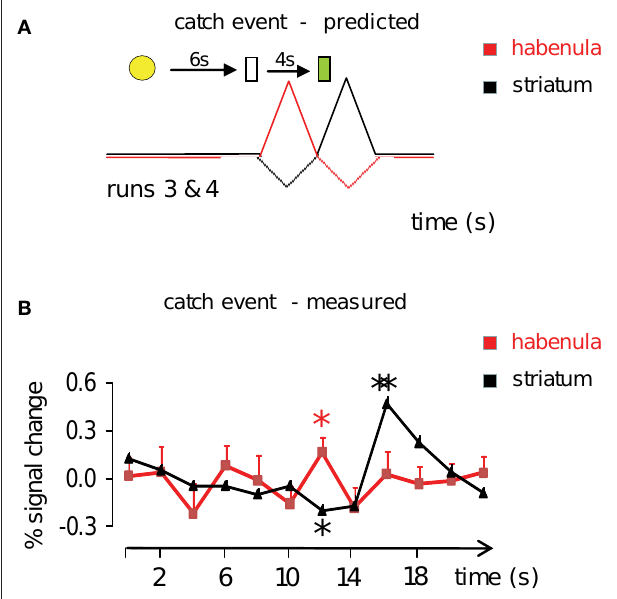
FIguRe  | Habenula activation to negative prediction errors. Striatal (black) and habenula (red) time series derived from 12 catch trials in runs 3 and 4 (see Figure  ). (A) Predicted (Based on Matsumoto and Hikosaka, 2007, we qualitatively drew the negative-going striatal and habenular responses as smaller than the positive responses.) and (B) . Measured habenular and striatal responses are shown. The red trace is the average time series from habenula voxels identified by the anti-correlational method presented in Figure  . The habenula voxels give a positive-going response to the non-delivery of expected juice ( p = 0.021). The striatal voxels were identified in Figure  with a standard GLM contrast and show a negative-going response to unexpected juice non-delivery (black asterisk, t-test p = 0.0014) and a positive-going response to unexpected juice delivery (black double asterisk, t-test p = 10 − 15 ). Ignoring the lack of response to the light cue, the only predicted response that is missing from the measured data is the lack of negative-going response in habenula voxels to unexpected juice